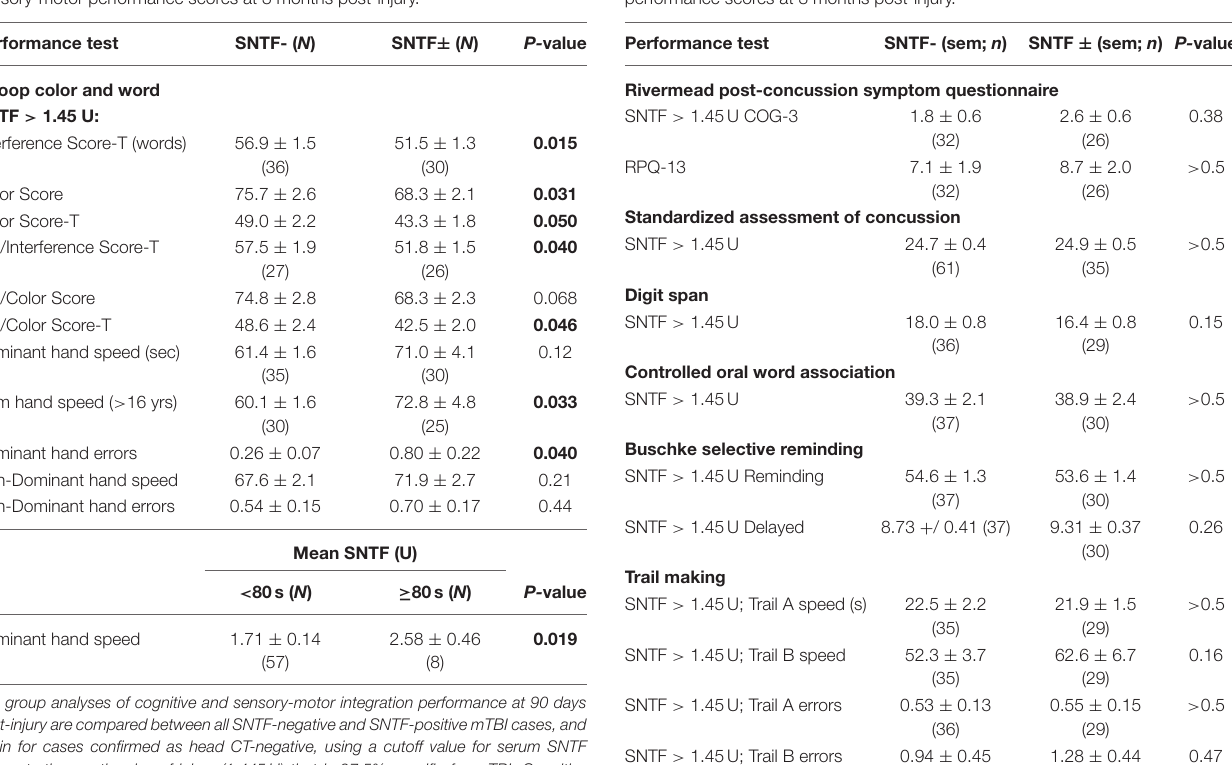
TABLE 3 | Serum SNTF on the day of mild TBI in relation to other brain performance scores at 3 months post-injury. Performance test